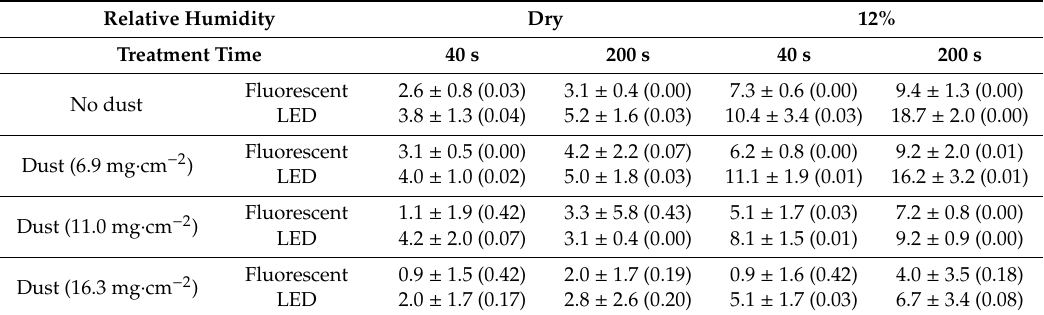
Table A3. NH 3 mitigation under the di ff erent dust levels at a relative humidity of dry and 12%. Values in the table report % reduction ± standard deviation ( p -value). Bold font signifies statistical significance.